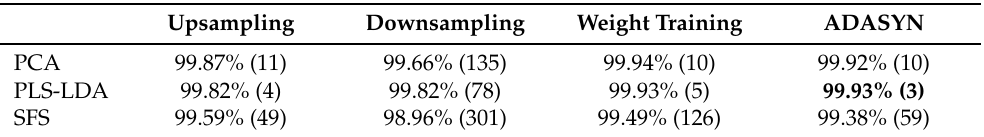
Table 8. Balanced accuracy score and the number of misclassified samples (values in parentheses) for predicting different types of equipment (Sedentary State/Treadmill Run/Stationary